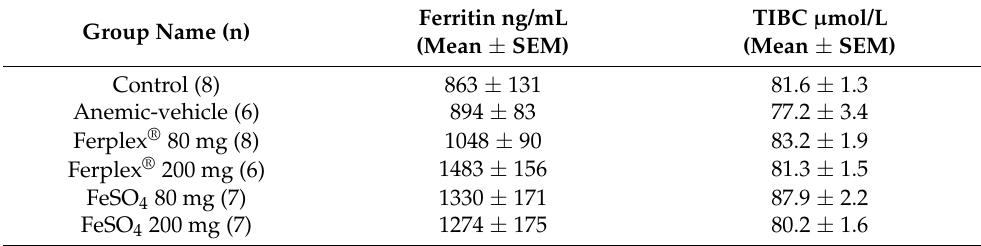
Table 2. Concentration of other biochemical markers on day